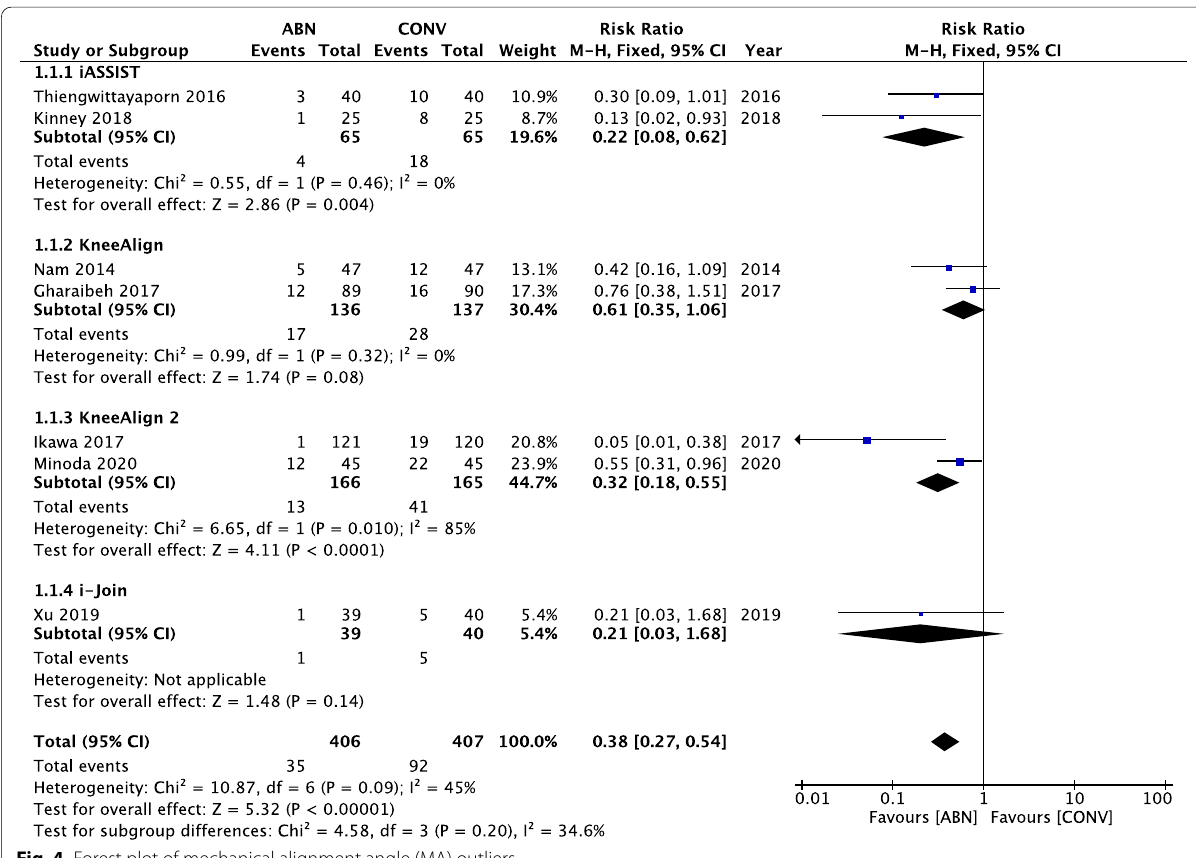
Fig. 4 Forest plot of mechanical alignment angle (MA)